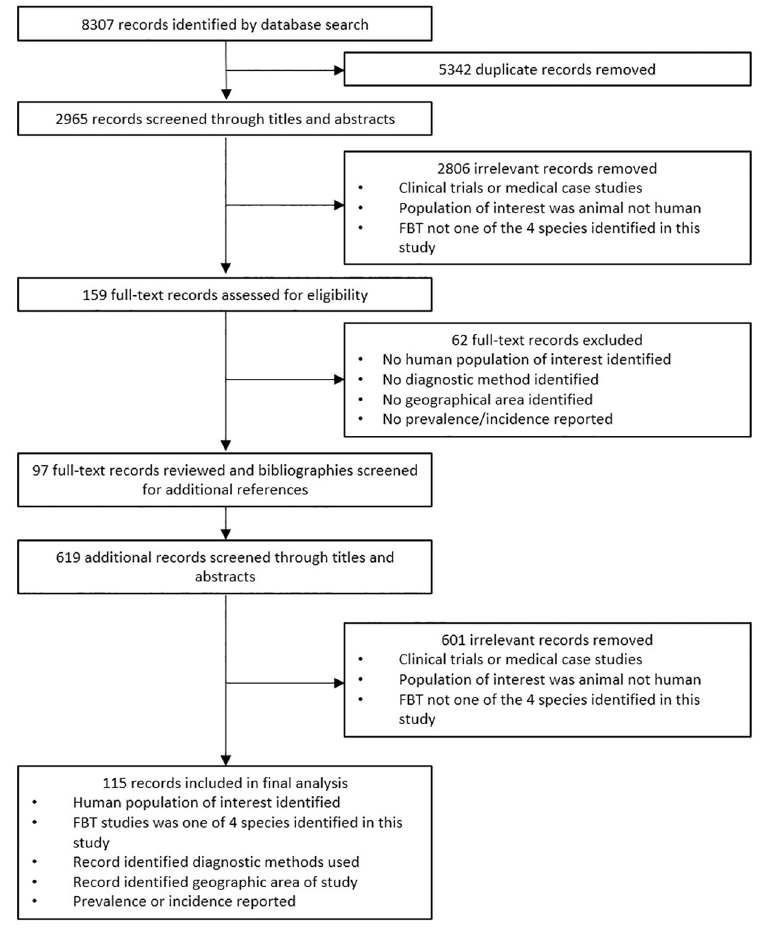
Fig 1. Flow diagram summarising the selection process of the studies in the review